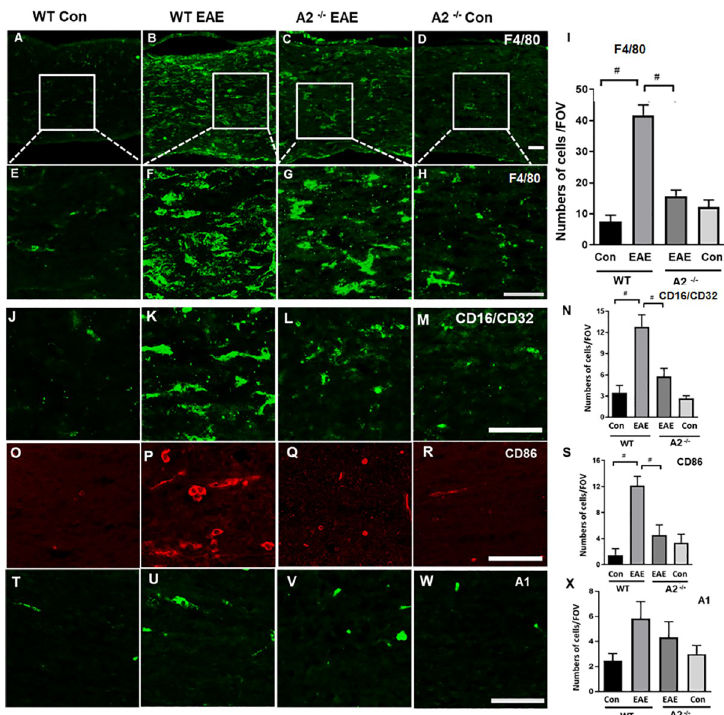
Fig 3. A2 deletion suppressed EAE-induced upregulation of F4/80 cells. A-D) Representative confocal images of optic nerve sections immunostained using F4/80 antibody. WT EAE optic nerves showed an increase in macrophage/ monocyte, while A2 deletion greatly suppressed this effect. E-H) Magnified images of boxed areas represent increase in the presence of F4/80 positive cells induced by EAE. I) Quantification of F4/80 positive cells demonstrate the impact of A2 deletion on the number of macrophages induced by EAE. Optic nerve sections stained using antibodies against CD 16/32 (J-M), and CD 86 (O-R) and quantification (N&Q) showed upregulation of M1 macrophages in WT EAE samples which was significantly reduced by the A2 deletion. Studies using an M2 marker, A1, did not show any significant changes across the groups (T-W) Number of animals used in the study: Number of animals used: 8(WT Control);12 (WT EAE); 9 (A2 -/- EAE); 7 (A2 -/- Control). Representative images are presented. Scale bar 50 μ m. Data are presented as Mean ± SEM. #p < 0.01 WT EAE vs WT Con and # p < 0.01 A2 -/- EAE vs WT